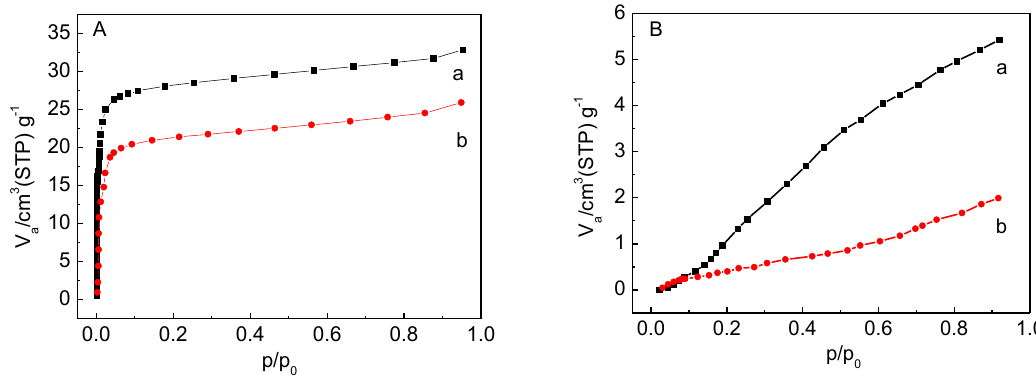
Figure 3. Adsorption isotherms of para-xylene (PX) ( A ) and meta-xylene (MX) ( B ) on HZSM-5 ( a ) and 5% P/HZSM-5 ( b ).